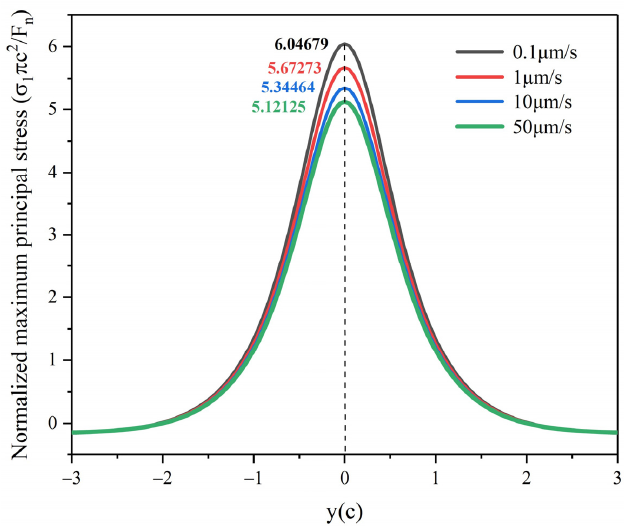
Figure 14. Normalized maximum principal stress at the depth z = c in the y–z plane under different scratch speeds.